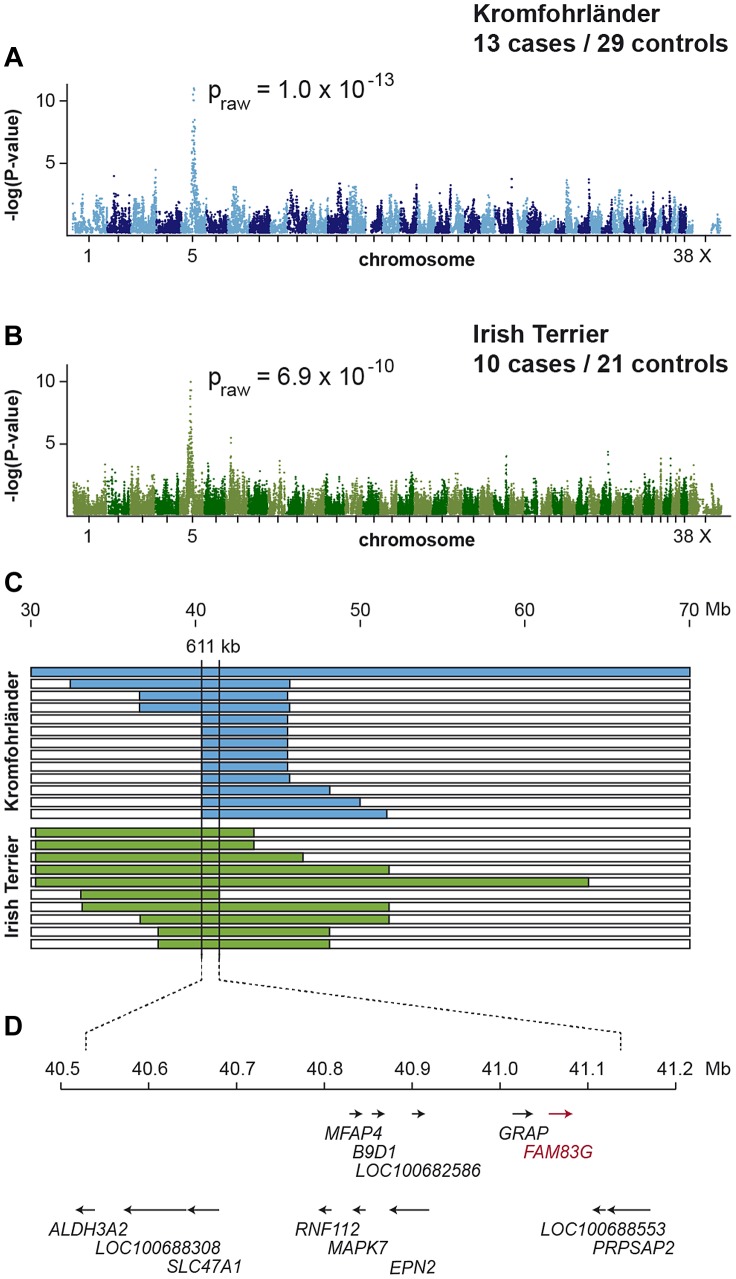
Mapping of HFH by GWAS and haplotype analysis.(A) A genome-wide association study in Kromfohrländer using 13 cases and 29 controls indicates a strong signal with multiple associated SNPs on CFA 5. (B) The association is replicated in a cohort of 10 Irish Terrier cases and 21 controls. (C) Homozygosity mapping. Each horizontal bar corresponds to one of the 23 analyzed cases. Homozygous regions with shared alleles are shown in color. A shared homozygous interval of 611 kb delineates the exact boundaries of the critical interval from 40,521,040–41,131,739 (CanFam 3.1 assembly). (D) NCBI gene annotation of the CanFam3.1 assembly in the critical interval.